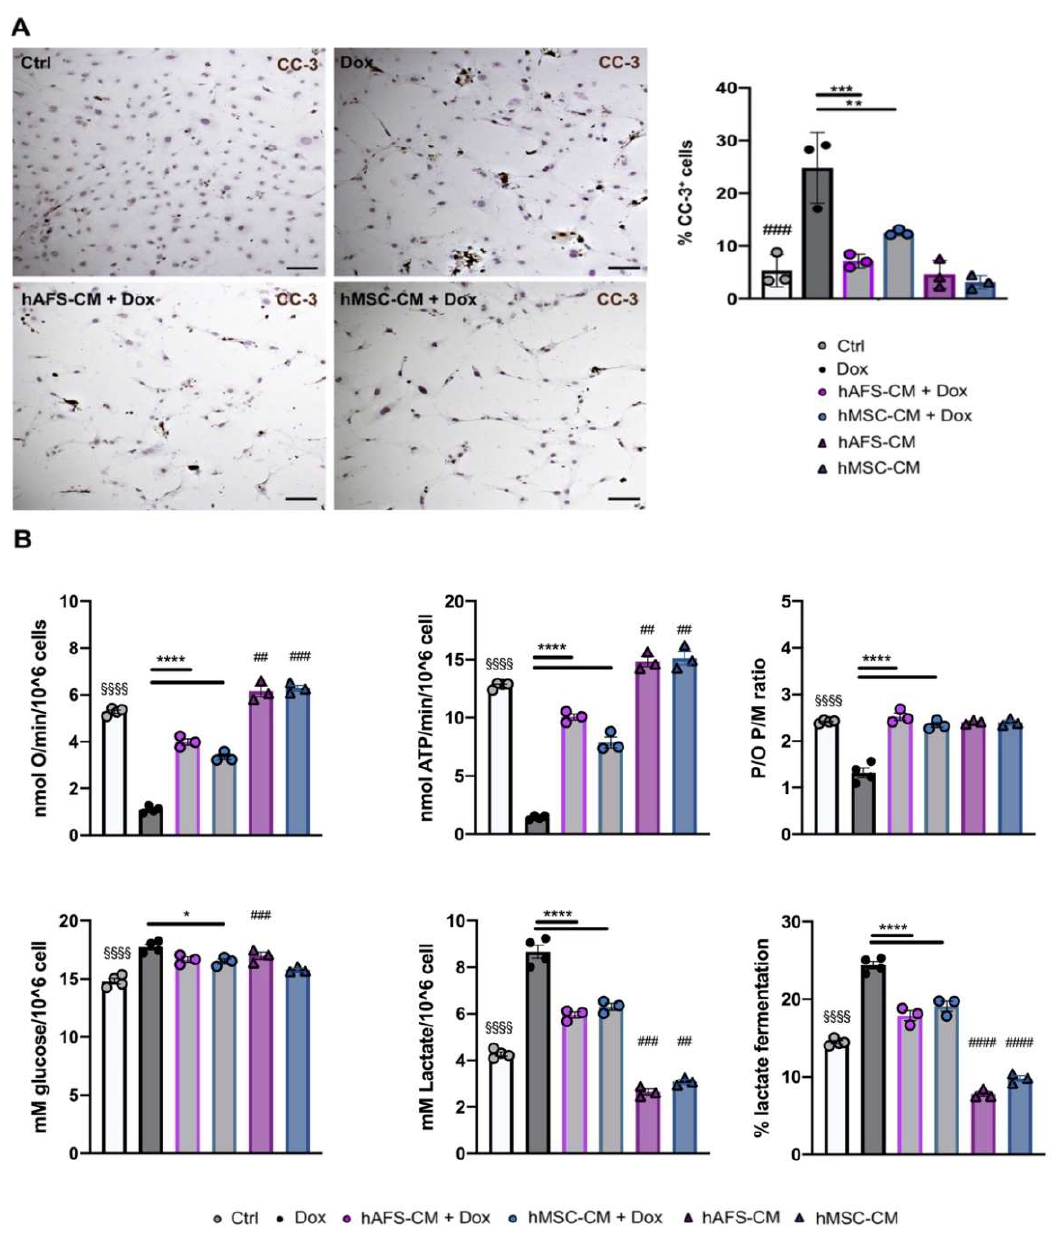
Figure 4. hAFS and hMSC secretomes induce pro-survival effects on mNVFib exposed to 1 µ M Dox and sustain their mitochondrial metabolism. ( A ) Left panel: representative images of immunocytochemistry analysis for the expression of cleaved-caspase 3 enzyme (CC-3) on untreated mNVFib ( Ctrl ) and on mNVFib exposed for 21 h to 1 µ M Dox with or without ( Dox ) previous priming with hAFS-CM ( hAFS-CM + Dox ) or hMSC-CM ( hMSC-CM + Dox ) for 3 h, scale bar: 20 µ m. Right panel: percentage of mNVFib expressing cleaved-caspase-3 (%CC-3 + cells) in control condition ( Ctrl : 5.31 ± 1.75%), after either hAFS-CM ( hAFS-CM : 4.65 ± 1.54%) or hMSC-CM ( hMSC-CM : 3.14 ± 0.74%) stimulation alone or after exposure to 1 µ M Dox with or without ( Dox : 24.83 ± 3.88%) pre-incubation with hAFS-CM ( hAFS-CM+Dox : 7.15 ± 0.72%) or hMSC-CM ( hMSC-CM + Dox : 12.52 ± 0.33%). Values are expressed as the mean ± SEM of n = 3 independent experiments; hAFS-CM vs. Ctrl and hMSC-CM . Ctrl: not significant; Ctrl vs. Dox : ### p = 0.0001; hAFS-CM + Dox vs. Dox : *** p = 0.0003 and hMSC-CM + Dox vs. Dox : ** p = 0.0064. ( B ) From the top left corner: Oxygen consumption rate stimulated with pyruvate plus malate; ATP production by F o -F 1 ATP synthase stimulated with pyruvate plus malate; mNVCM